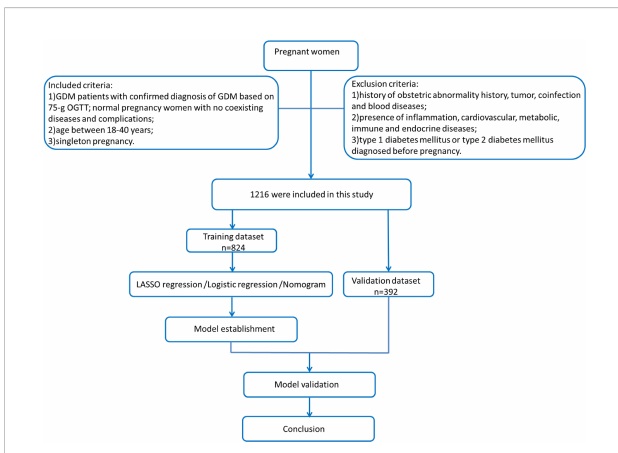
FIGURE 1 Flowchart of this study. A total of 1,216 pregnant women enrolled in our study were selected by inclusion criteria. The training dataset ( n = 824) was used to estimate a GDM predictive model, and our study applied LASSO logistic regression and multivariate ROC risk analysis to determine signi fi cant predictors and establish the nomogram. A total of 392 early pregnant women were used as a validation dataset. We evaluate the nomogram by AUC, C-index, calibration curve, and decision curve analysis